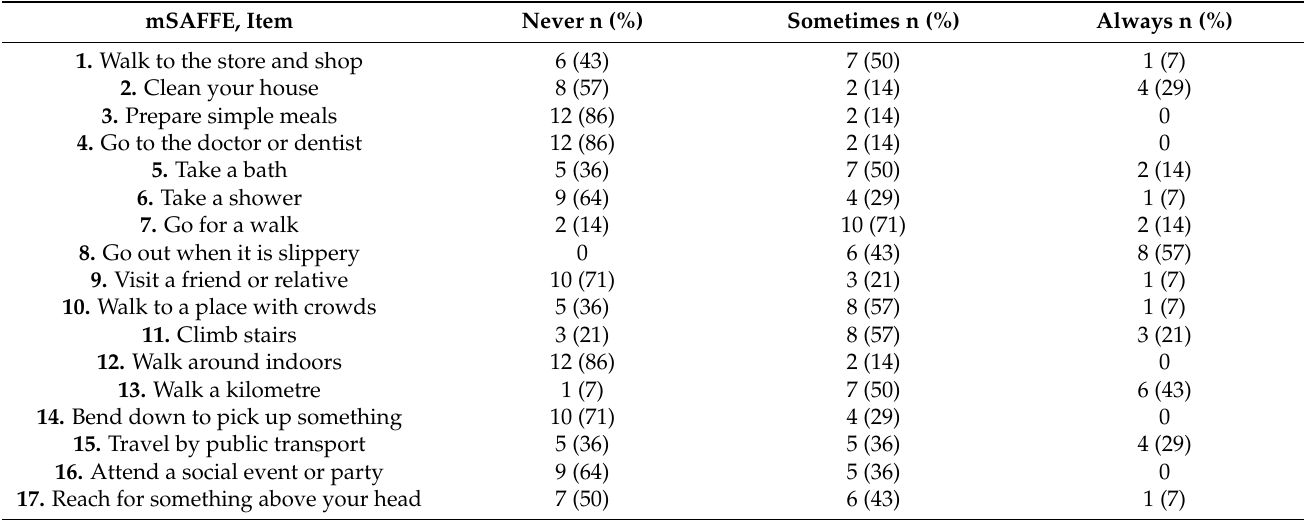
Table 2. Occurrence of fall-related activity avoidance in persons with late effects of polio. mSAFFE,